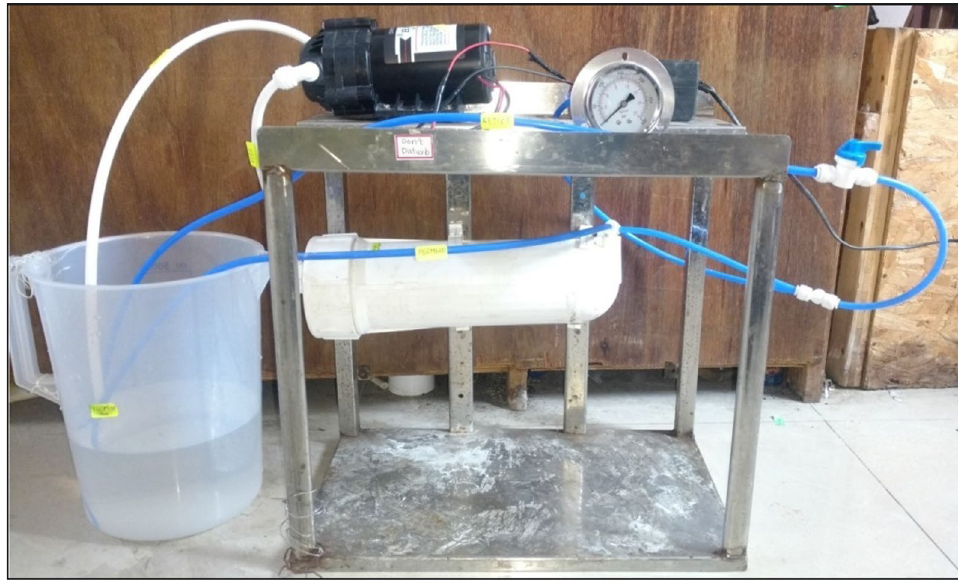
Fig. 4 Experimental setup for modification of RO